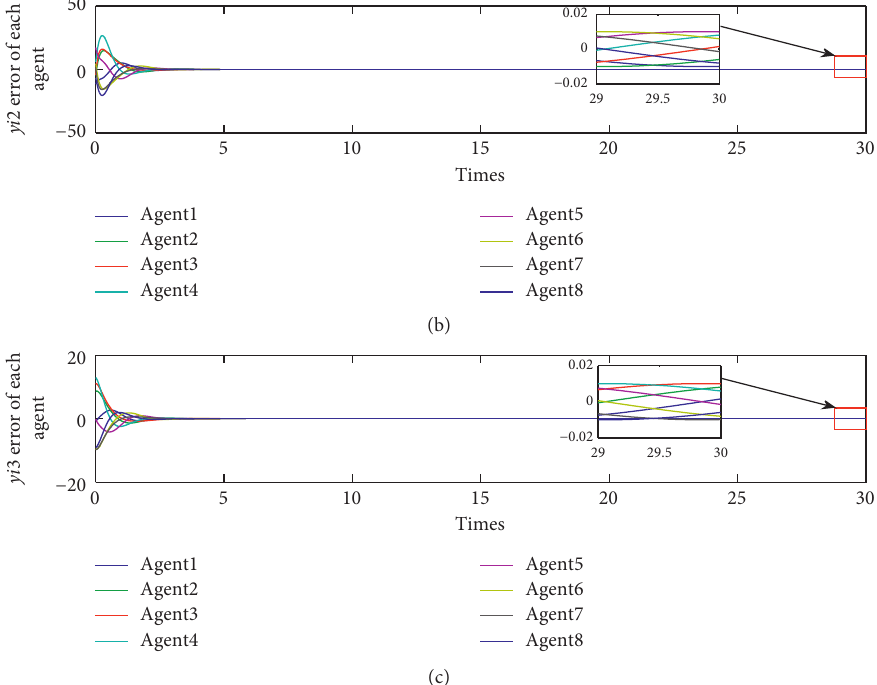
Figure 5: Output error of eight agents with the robust compensator.